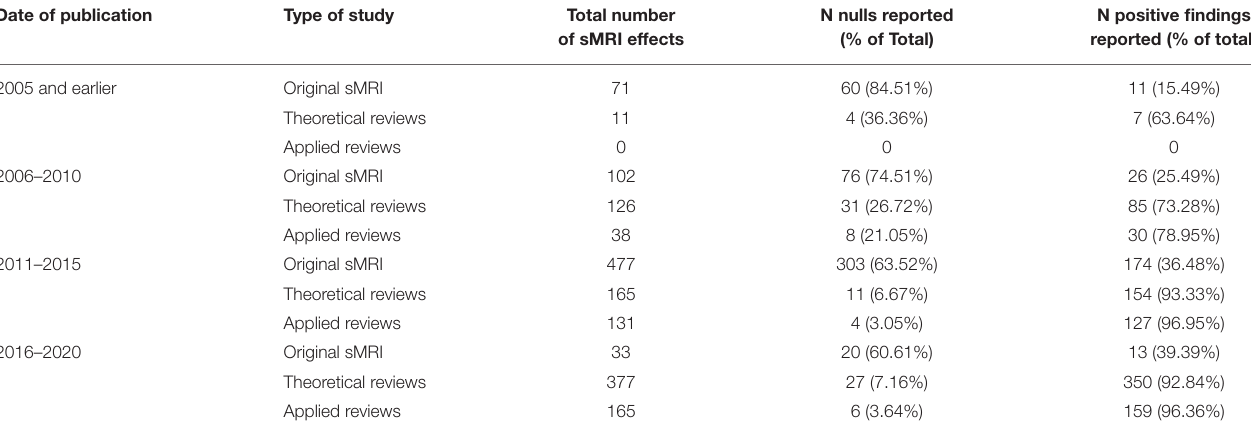
TABLE 3 | Null sMRI findings reported over